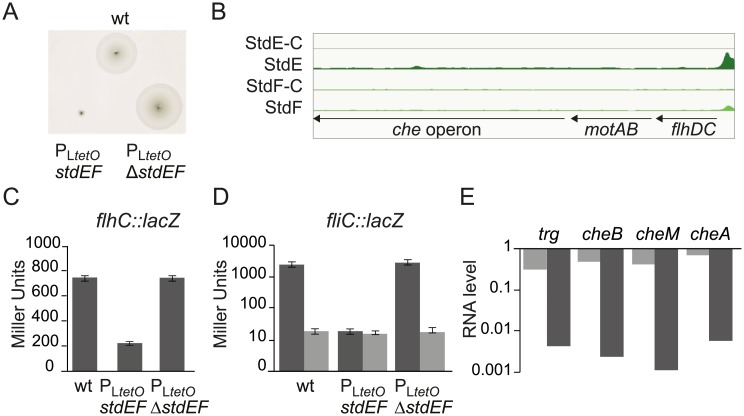
Flagellar control by StdE and StdF.A. Motility of strains SL1344 (wt), PLtetO-stdEF (SV8141) and PLtetO-ΔstdEF (SV8142). The experiments were performed for at least three biological replicates, and a representative experiment is shown. B. StdE and StdF binding peaks in the flhDC region. StdE-C and StdF-C indicate binding peaks found for the mock IP-sample. C. β-galactosidase activity of a flhC::lacZ fusion. Constitutive expression of stdEF (SV9289) results in low level of flhC expression, compared with the wild type strain (SV9288) and with the control strain PLtetO-ΔstdEF (SV9290). D. β-galactosidase activity of a fliC::lacZ fusion showing that StdE and StdF regulation of the flagellar system take place through FlhDC. Dark grey bars represent FlhC+ and light grey bars represent FlhC–. E. Ratios (PLtetO-stdEF / PLtetO-ΔstdEF) of mRNA levels of genes involved in chemotaxis in the strains PLtetO-stdEF and PLtetO-ΔstdEF. RNA levels were determined for at least 3 biological replicates and a representative experiment is shown. As above, dark grey bars represent FlhC+ and light grey bars represent FlhC–.